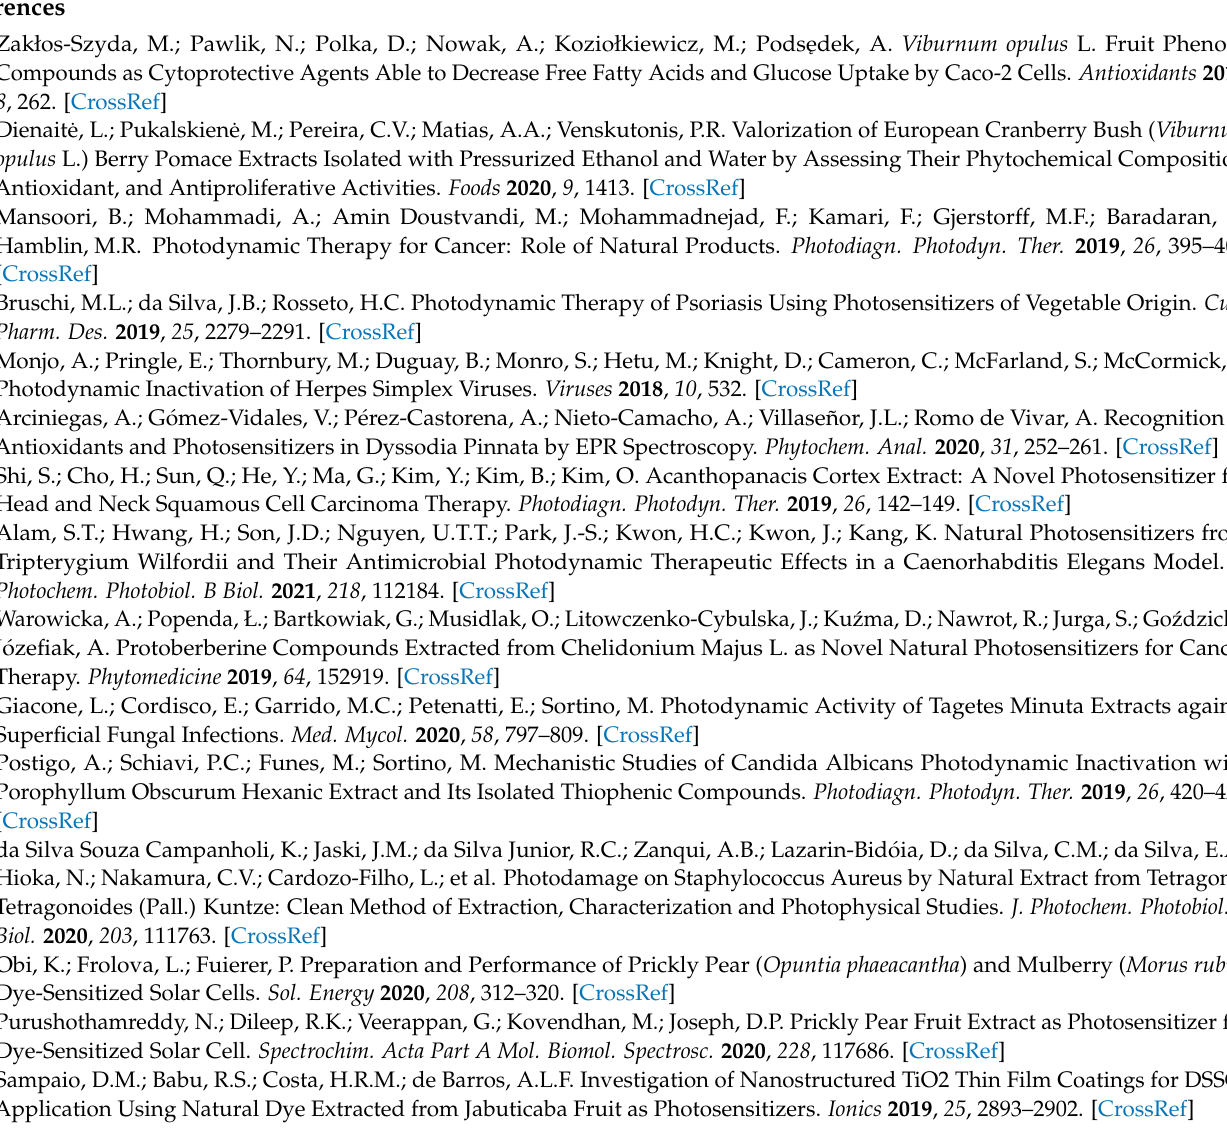
measurements. Table S2: The results of antioxidant activity obtained by the amperometric method. Table S3: The results of antioxidant activity obtained by the FRAP method. Table S4: The results of antioxidant activity obtained by the DPPH method. Table S5: The results of antioxidant activity obtained by the ABTS